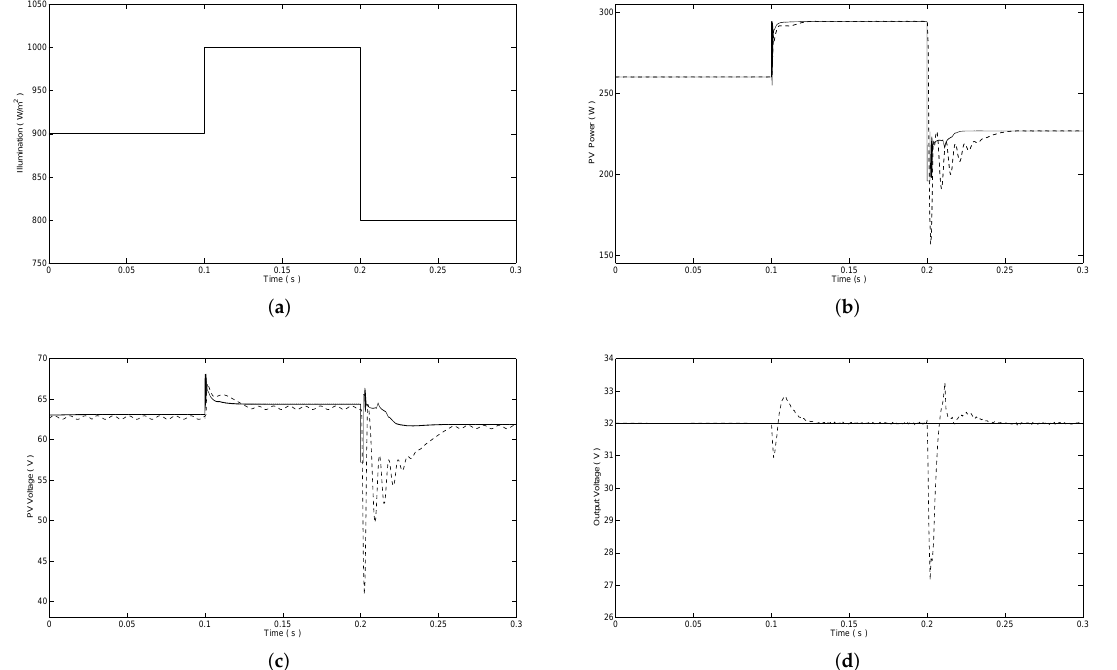
Figure 10. ( a ) The illumination variation; ( b ) corresponding output power; ( c ) output voltage of PV module; and ( d ) output voltage of DC-DC buck converter (proposed method ( ), traditional P&O and PI cascade control ( −−